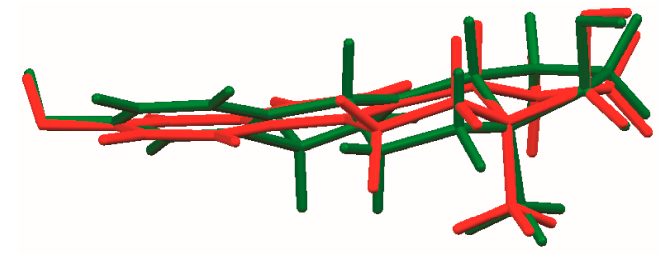
Figure 4. Comparison of the molecular structures of C 18 H 20 O 2 (red) and C 18 H 22 O 2 (green), viewed approximately in the plane of the ring system.